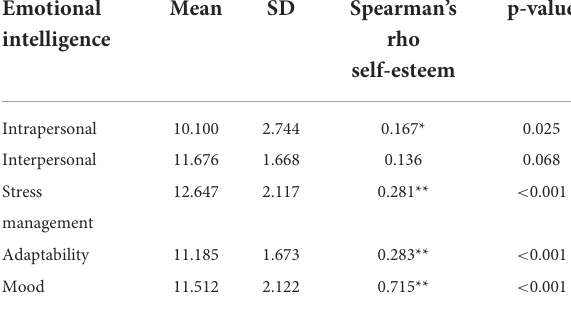
TABLE 2 Emotional intelligence: descriptive statistics and correlation with global self-esteem ( N =